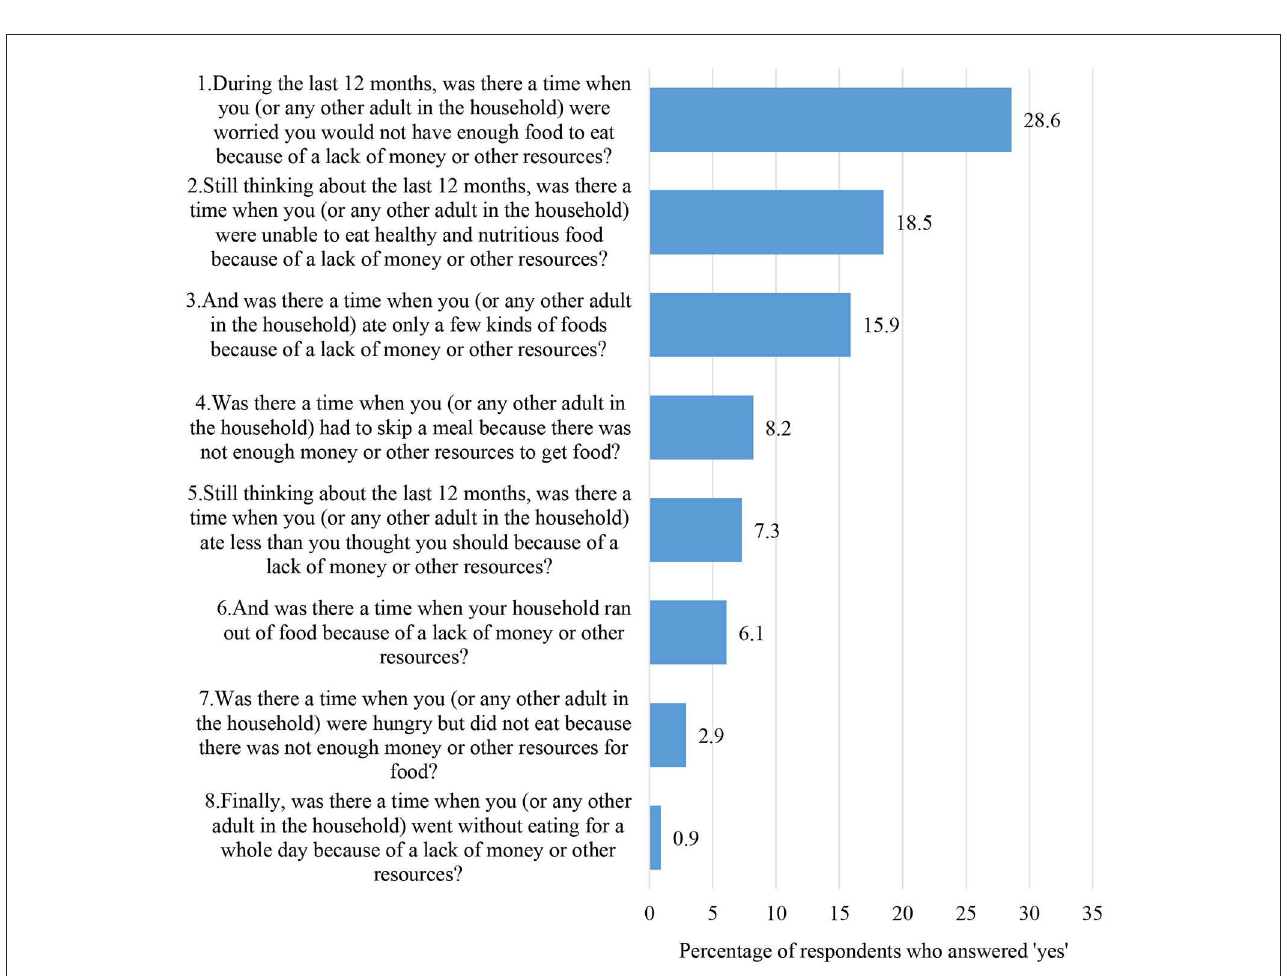
FIGURE1 Respondents who answered “ yes ” by each of eight FIES questions (%).